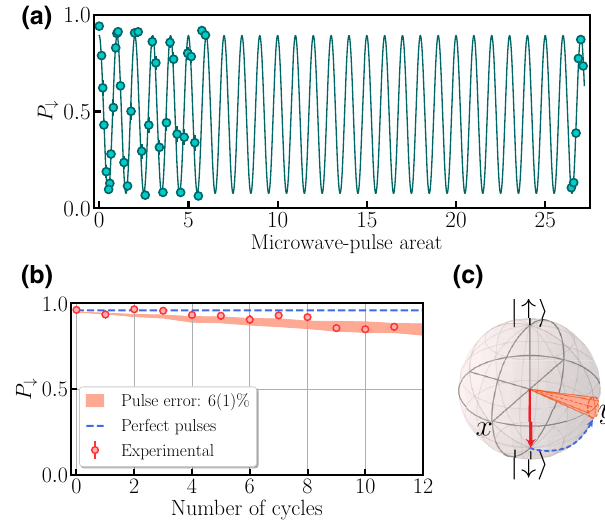
FIG. 5. The calibration of microwave-pulse error. (a) Microwave Rabi oscillations between states |↑(cid:2) and |↓(cid:2) . The Rabi frequency is (cid:4) = 2 π × 13.2 MHz. (b) The probability P ↓ of measuring a single atom in |↓(cid:2) following H XXX versus the number of cycles. The data are shown as red circles, with the simulated pulse sequence results for perfect pulses shown in blue and with a pulse error (cid:11)θ = 0.06 ± 0.01 as the shaded pink region. (c) An illustration of how the error is included in the simulation: the final Bloch vector after a rotation around any axis (here, the x axis) lies inside the orange